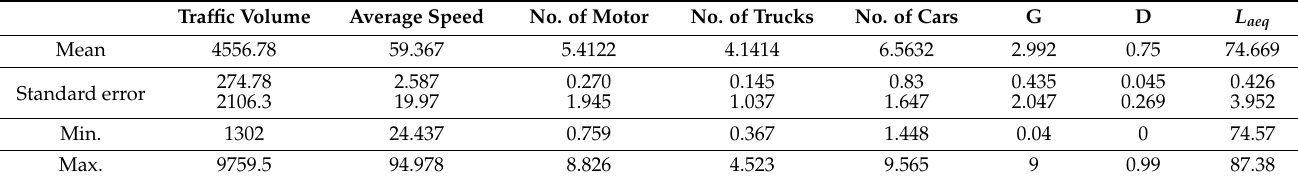
Table 3. Descriptive statistics of